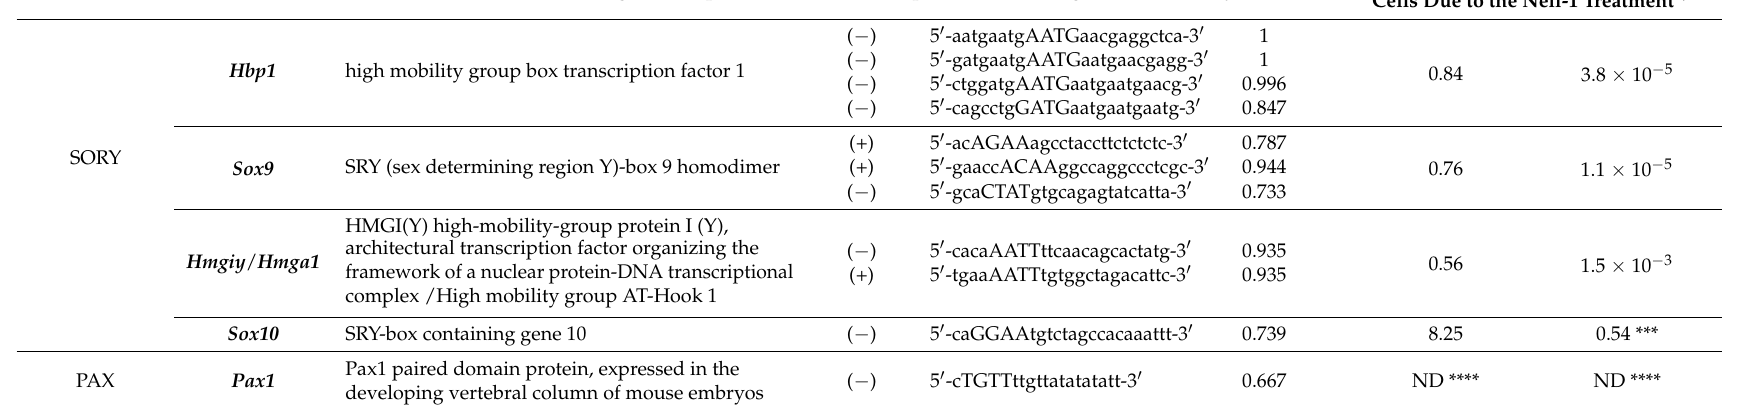
In Silico Bioinformatics Predicted Mouse Runx3 Promoter Binding Transcriptional Factors That Expressed in Cartilage and Chondrocytes